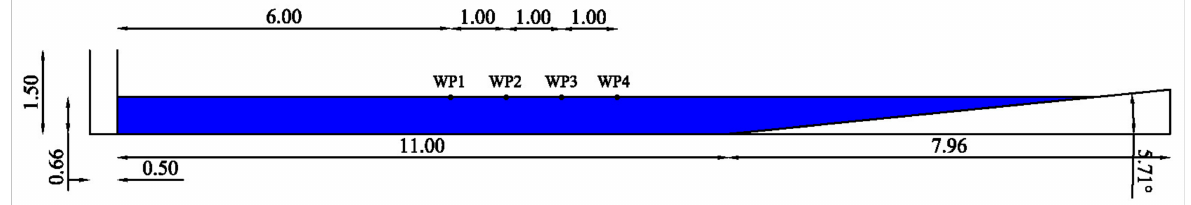
Figure 11. Schematic of the numerical wave tank used for the simulations. The height of the piston type wave maker is 1.5 m.